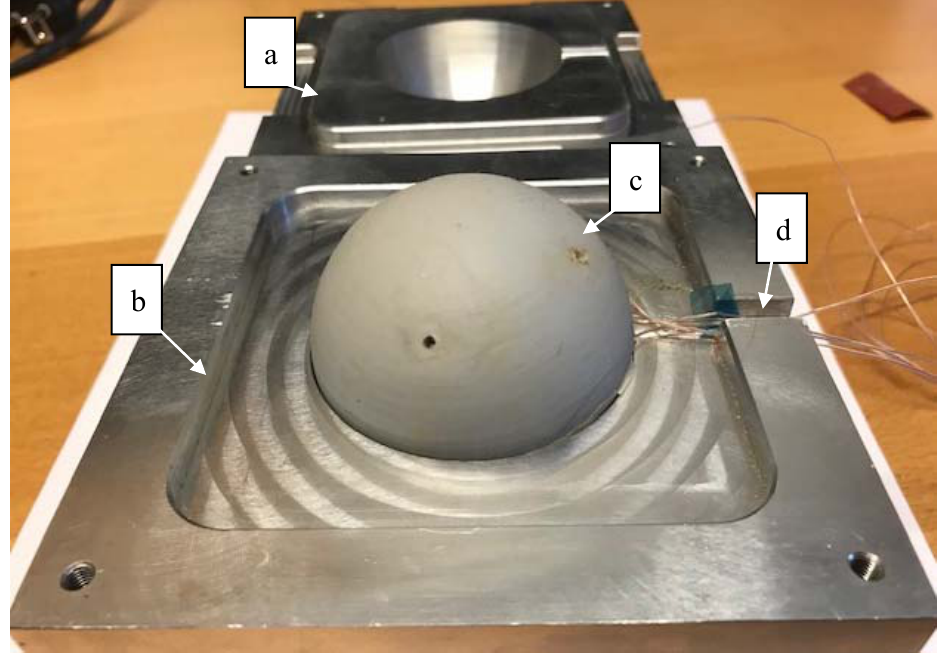
Figure 6. Temperature change test set ‐ up: ( a ) top mold; ( b ) bottom mold; ( c ) rubber specimen; ( d ) data acquisition channel.